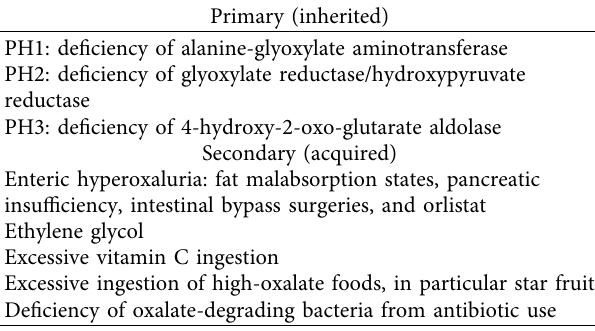
Table 2: Primary and secondary causes of